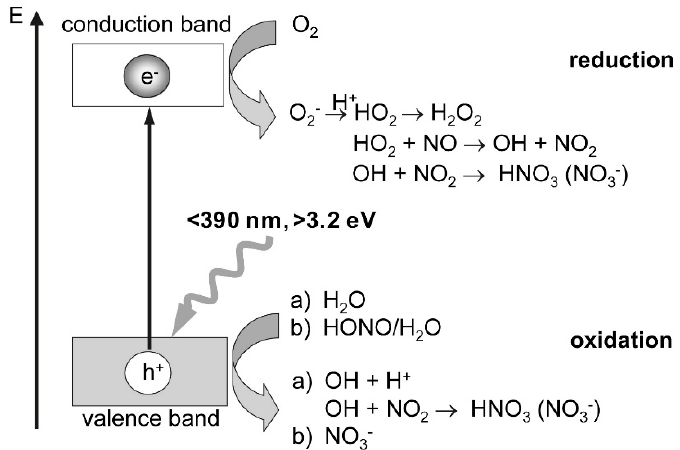
Figure 52. Postulated mechanism for the photocatalytic reactions of NO, NO 2 and HONO on photoactive paint surfaces. Reproduced with permission from Laufs et al. [156]. Copyright 2010 by Elsevier Ltd. (License No.: 4453150462958).